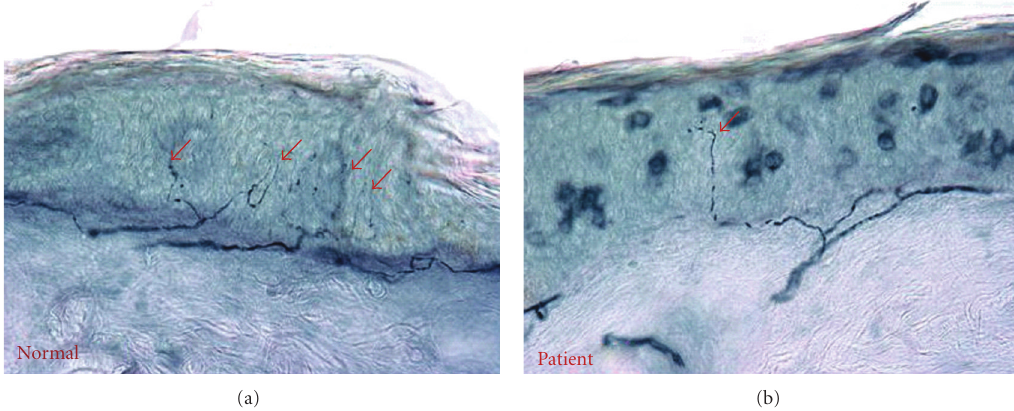
Figure 1: PGP9.5 immunostaining of skin biopsies at the distal leg. The patient with painful diabetic neuropathy (b) showed reduced intraepidermal nerve fibers (red arrow), in comparison to a normal subject (a) who showed many intraepidermal nerve fibers (red arrows).